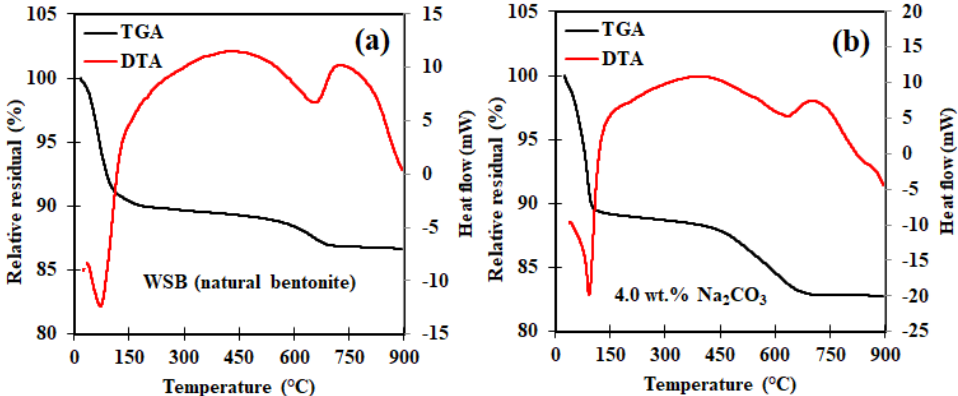
Figure 2. TGA and DTA curves for WSB ( a ) and 4 wt.% Na 2 CO 3 ( b ).